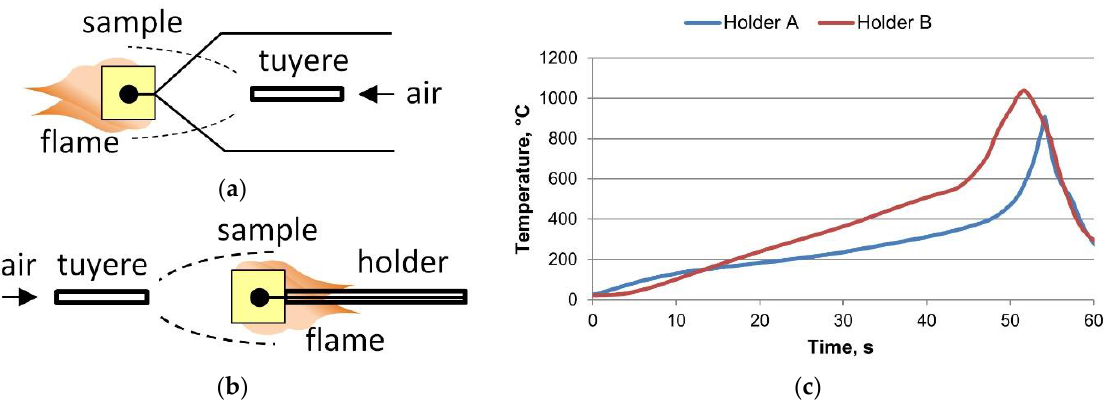
Figure 3. Types of particle holders ( a , b ) and their differences in recording temperature ( c ) given furnace temperature of 800 °C and air velocity of 20 m s −1 .